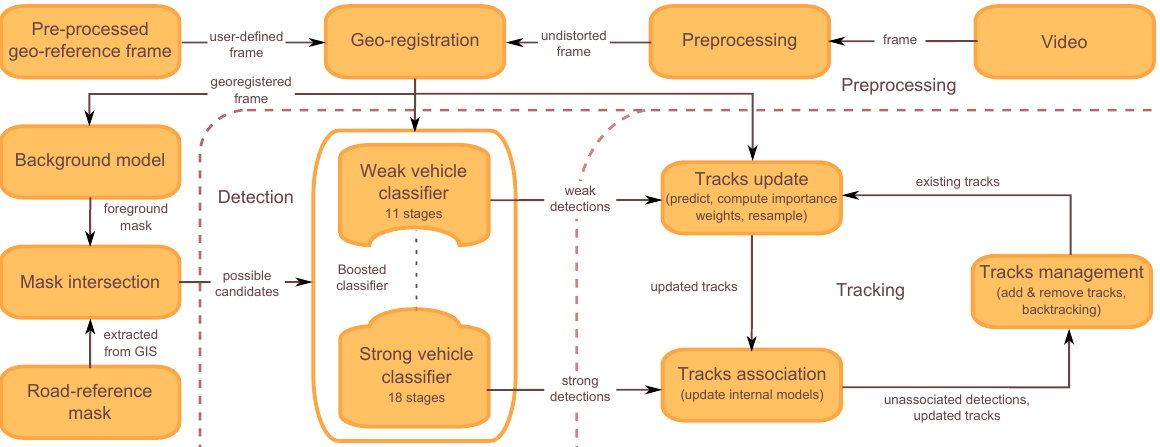
Figure 1. System architecture – the Boosted classifier is divided into two parts, the weak and the strong classifier. The detections taken from the strong classifier are used for initialization of new targets and/or for the update of the appearance models of existing targets when an association occurs. The detections returned by the weak classifier are used as clues in the tracking